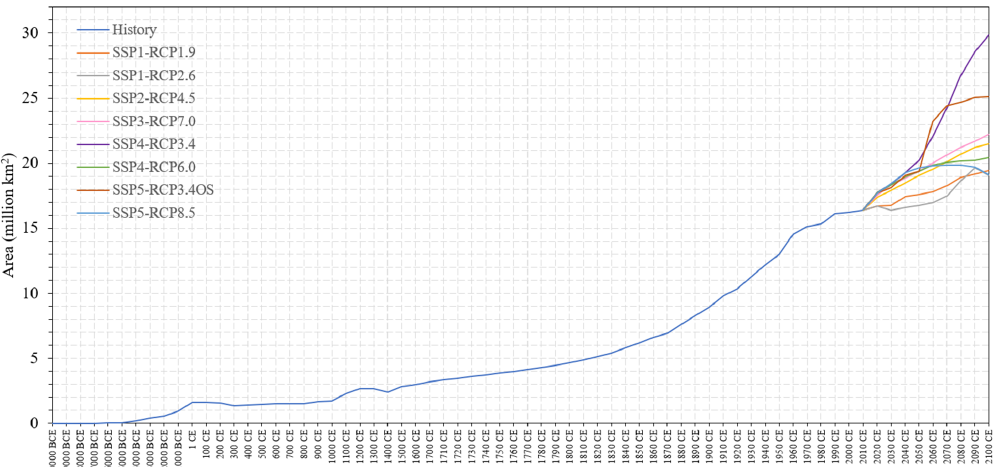
Figure 9. Global cropland area from 10000BCE to 2100CE.